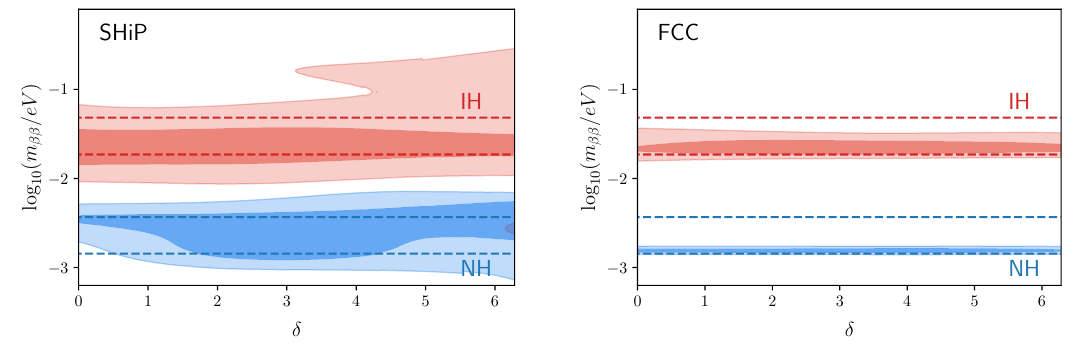
Figure 16 . 1 and 2 σ regions from the numerical scan on the plane ( δ, m ββ ) at ∆ M/M = 10 − 2 for NH (blue) and IH (red). The standard light neutrino contribution is contained in the dashed bands. The left plot corresponds to the SHiP range and the right plot to the FCC